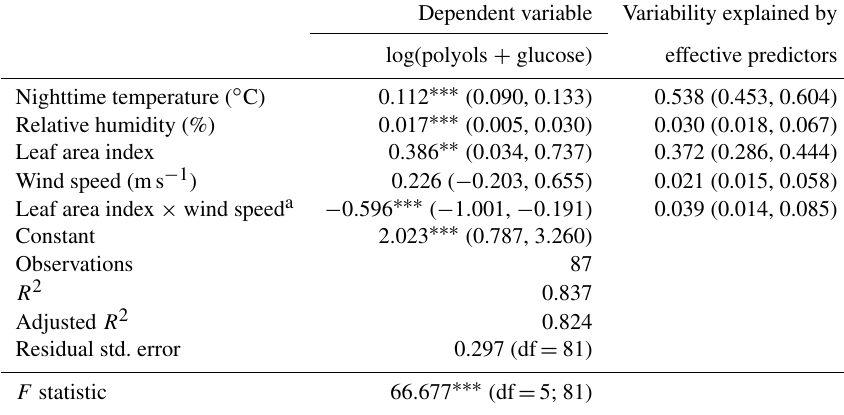
Table 1. Multiple linear regression for ambient polyol and glucose concentrations and their effective environmental factors at the Marnaz site. Contributions of predictor are normalized to sum 1. The “Relaimpo package under R” was used to compute bootstrap confidence intervals for the importance of effective predictors ( n = 1000) (Grömping,